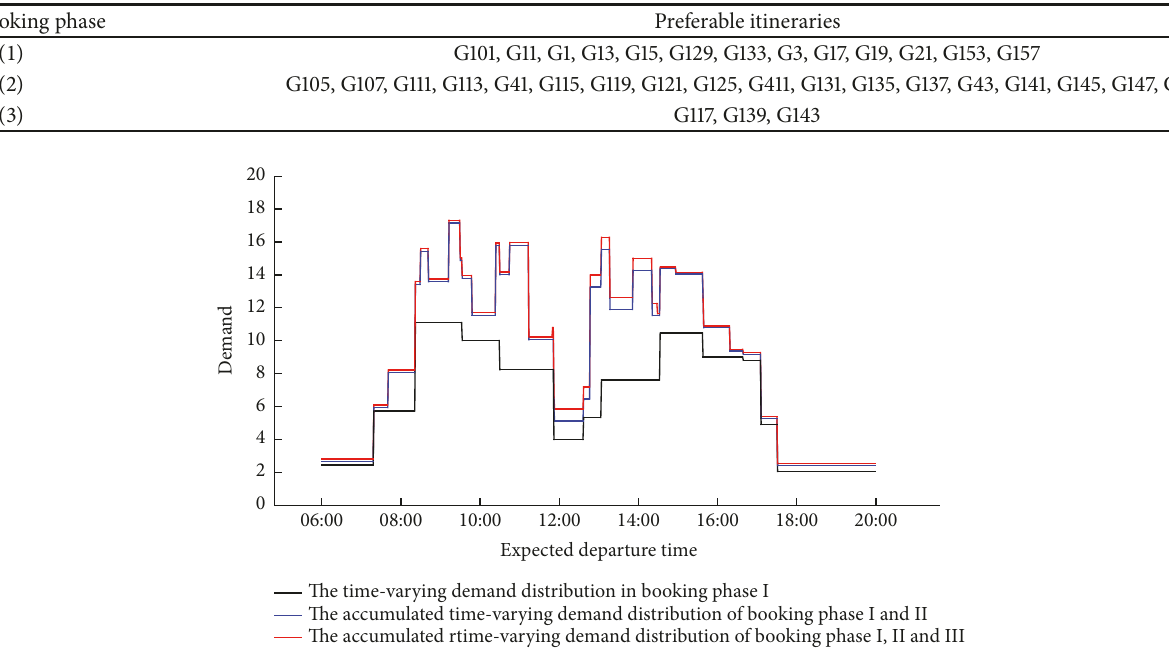
Figure 7: The accumulated time-varying demand distribution of the SBPRA